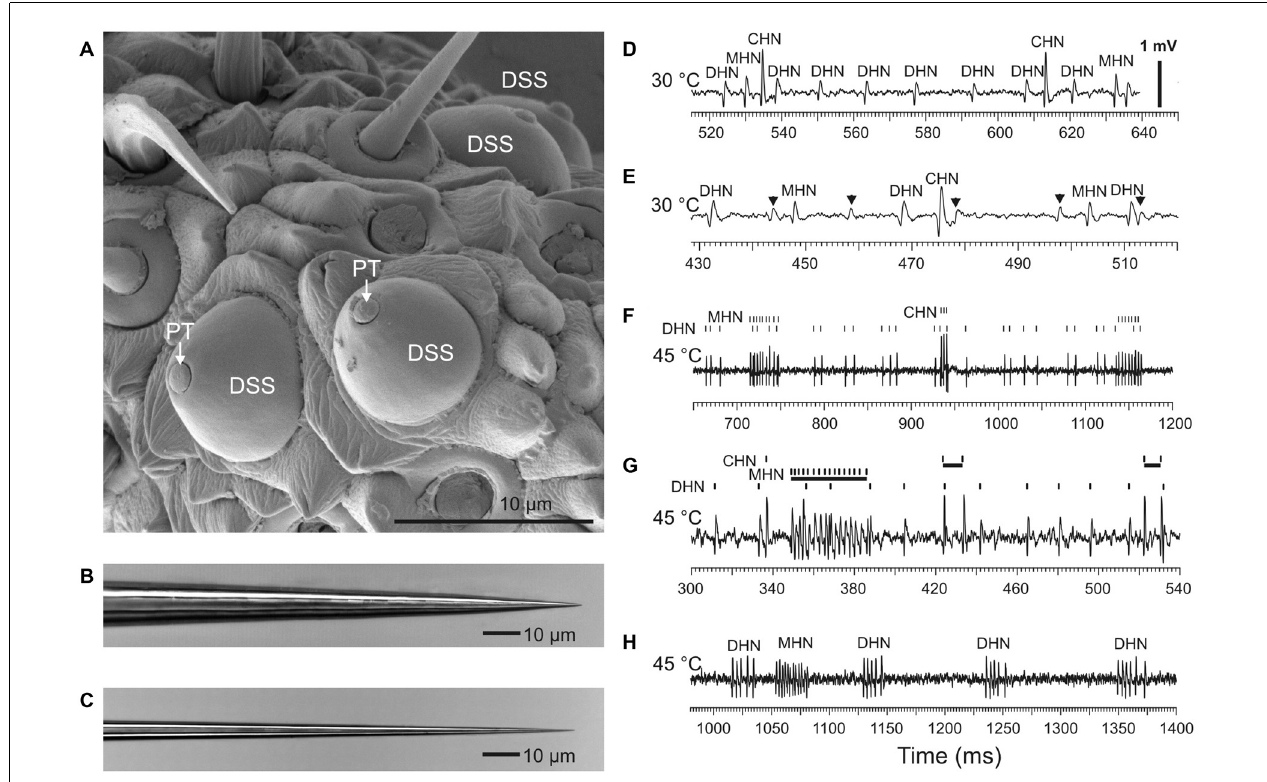
FIGURE 1 | Recording spike firing activity of the sensory neurons innervating antennal dome-shaped sensilla (DSSs) in A. obscurus . (A) SEM image of a group of DSSs at the tip of the terminal flagellomere favorable for electrophysiological recordings. Note that only a small tip of the sensillum peg (PT) is directly exposed to ambient air. Panels (B,C) show tip profile of the tungsten indifferent and recording microelectrode, respectively. The recording electrode used was approximately 0.6–0.8 µ m in diameter at a distance of 5 µ m from the tip. (D) At moderate temperatures up to 30 ◦ C, the recording microelectrode typically picked up three different spike waveforms belonging to cold-hot neuron (CHN), moist-hot neuron (MHN), and dry-hot neuron (DHN), respectively. The spikes produced by the CHN were always conspicuously the largest in amplitude. (E) In rare cases, the number of spike shapes recorded in a DSS was four, however. The spikes from the “fourth” neuron were always very small, hardly distinguishable among the noise fluctuations in most cases. They originated from some of the adjacent sensilla. In this particular recording, the relatively large spikes from the “fourth” neuron, indicated by arrows, probably arose from the CHN of a neighboring DSS. The spike trains produced by the “fourth” neuron were omitted in this study. (F) At high temperatures, the sensory neurons in DSS switched from regular firing to burst firing mode. (G) In one and the same DSS, the sensory neurons had a different threshold temperature for spike bursting. In this particular sensillum, at 45 ◦ C, spike bursts were only produced by the MHN and CHN while the DHN fired regularly. A sample recording made at 45 ◦ C from another DSS demonstrated that high-frequency spike bursts were produced by the MHN and DHN (H) . Note that the CHN stopped spike production completely. All the recordings were made from different